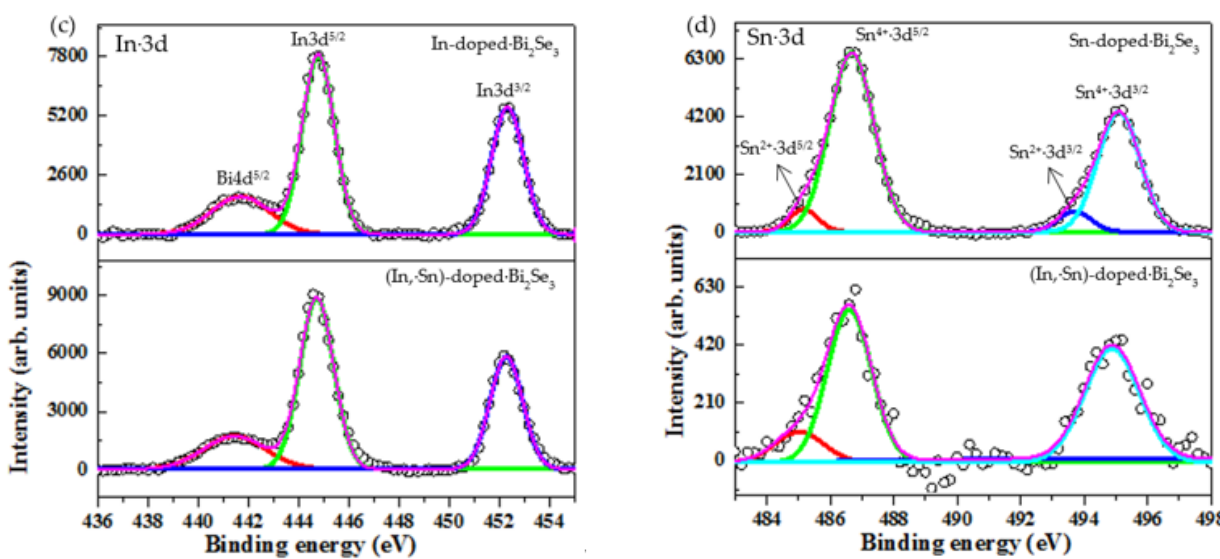
Figure 4. XPS spectra of ( a ) Bi 4f, ( b ) Se 3d, ( c ) In 3d, and ( d ) Sn 3d in pristine, and Sn-, and (In, Sn)-doped Bi 2 Se 3